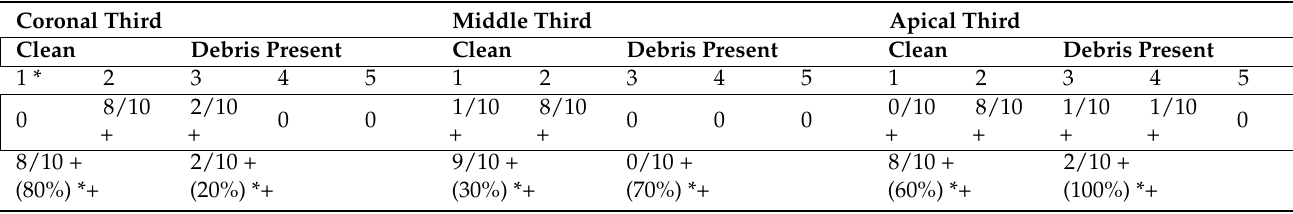
Table 13. Group 1: Debris score with 0.2% PO-AMNE.